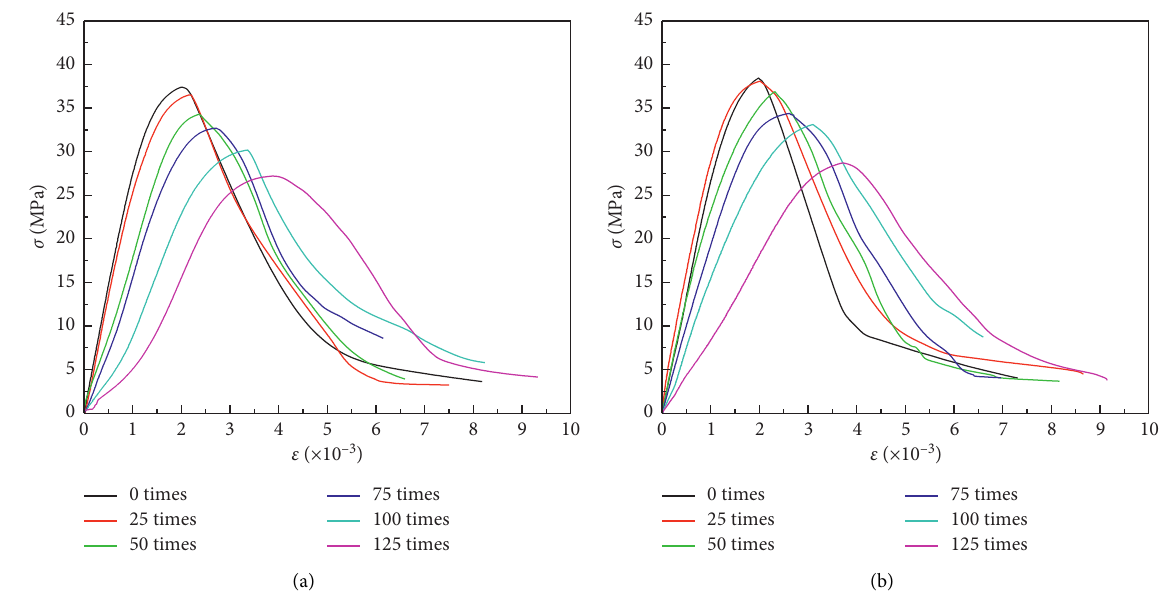
Figure 17: Stress-strain curve of OC and DSC with 50% DSRR under different freeze-thaw cycles. (a) OC. (b) DSC with 50%